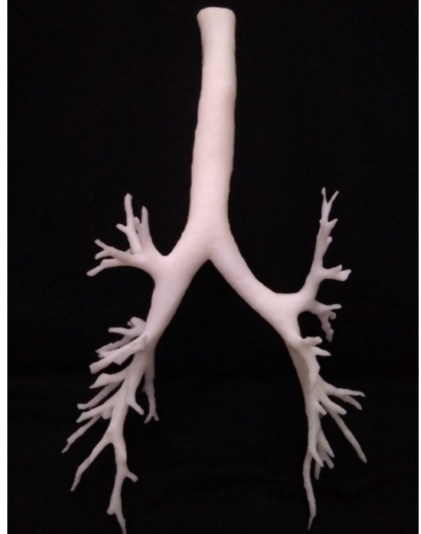
Figure 17. 3D printed pulmonary